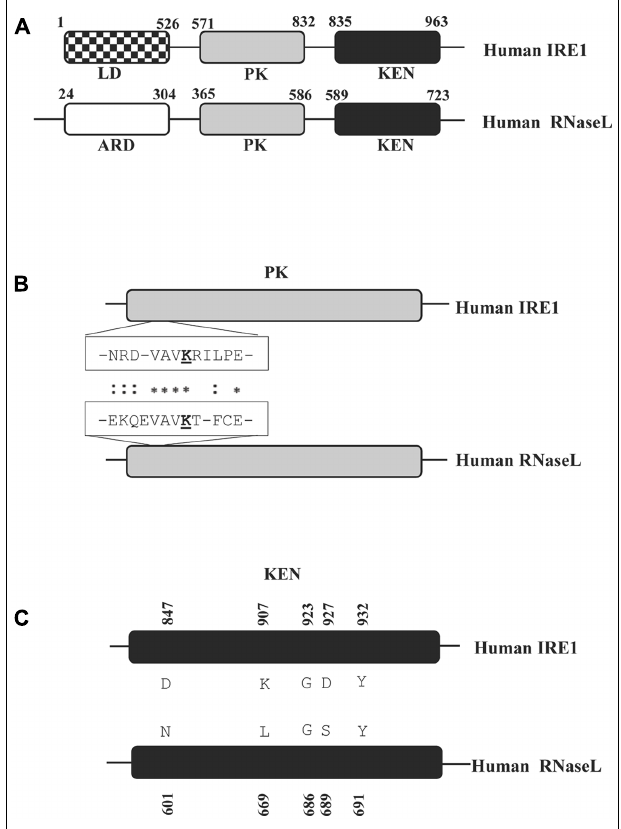
FIGURE 2 | Schematic representation of distinct protein domains in human RNaseL and IRE1. (A) The domains homologous between RNaseL and IRE1 are shaded identically.The domain name abbreviations denote the following: ARD = ankyrin repeat domain; LD = luminal domain; PK = protein kinase domain; KEN = kinase extension nuclease domain.The amino acid positions bordering each domain are numbered.The schematic drawings are not according to scale. (B) ClustalW alignment of primary sequence from a segment of the PK domain indicating amino acid residues which are important for interacting with nucleotide cofactors.The conserved lysine residues, critical for this interaction (K599 for IRE1 and K392 in RNaseL) are underlined. (C) Alignment of the KEN domains in RNaseL and IRE1.The amino acids highlighted and numbered in IRE1 are critical for the IRE1 RNase activity (Tirasophon etal.,